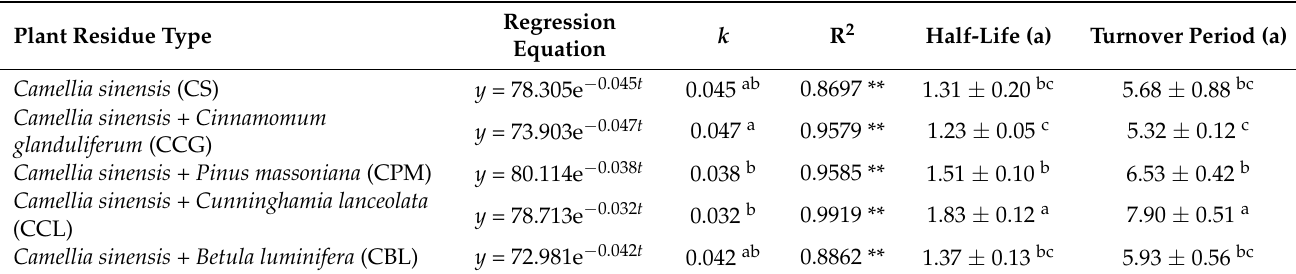
Table 2. Regression model of the decomposition of dry matter determined by mass loss of plant